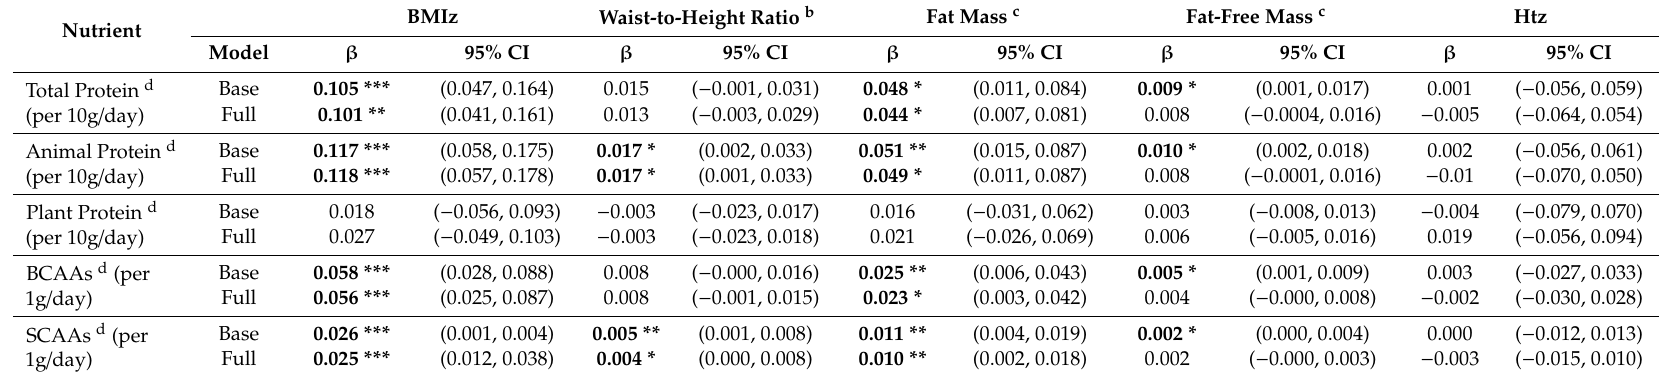
Table 5. Associations a between dietary protein and amino acid intake and weight status, central adiposity, and body composition.